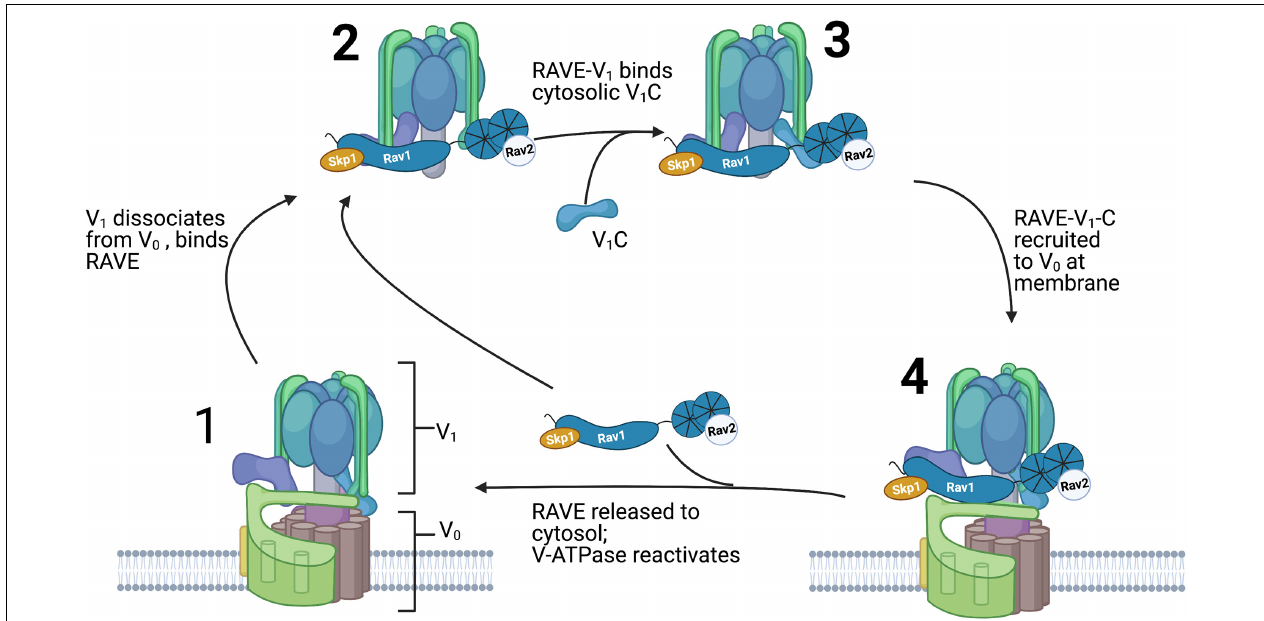
FIGURE 4 | Order of events in RAVE-driven catalysis of V-ATPase reassembly. Assembled and active V-ATPases (1) are dissociated upon glucose deprivation as described in Figure 2 . The RAVE complex binds to cytosolic V 1 complexes (2) and this RAVE-V 1 complex then binds to subunit C (3). After glucose readdition, RAVE is recruited to V o complexes at the vacuolar membrane and catalyzes recruitment and functional reassembly of V 1 and subunit C with V o complexes (4). RAVE is then released and able to catalyze another cycle of reassembly.